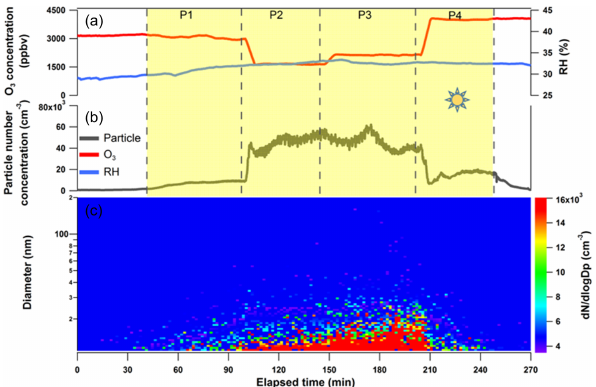
Figure 4. Irradiation experiment for SML CAT 8 sample in a quartz cell and subsequent particle formation from the SML interfacial gaseous products via OH radical photochemistry in the OFR. The (a) O 3 mixing ratio and humidity in the OFR; (b) particle concen- tration measured by CPC; and (c) particle size distribution profiles scanned by SMPS downstream of the OFR. The yellow shading represents the time period in which the quartz cell containing the concentrated SML sample was illuminated. P1 to P4 correspond to different operations to the OFR in varying oxidation degrees of the gaseous products from the quartz